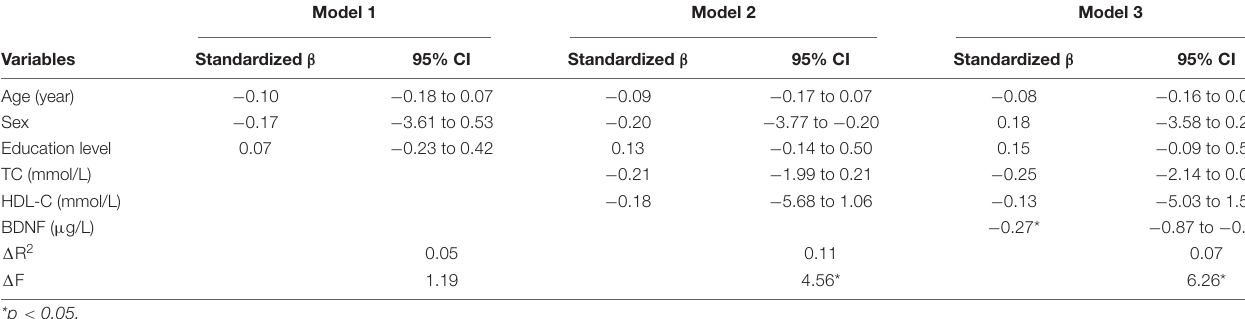
TABLE 3 | Hierarchical multiple regression analysis of factors associated with LMT score in T2DM more than 10 years.